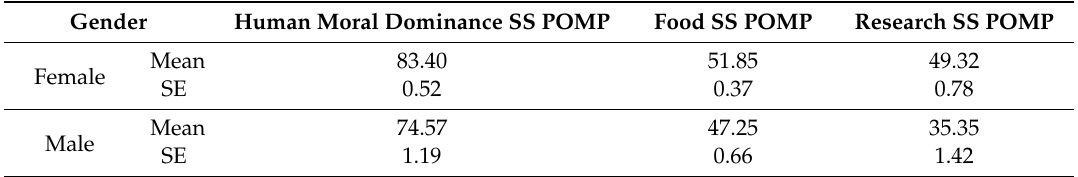
Table 1. Gender differences in subscale POMPs.